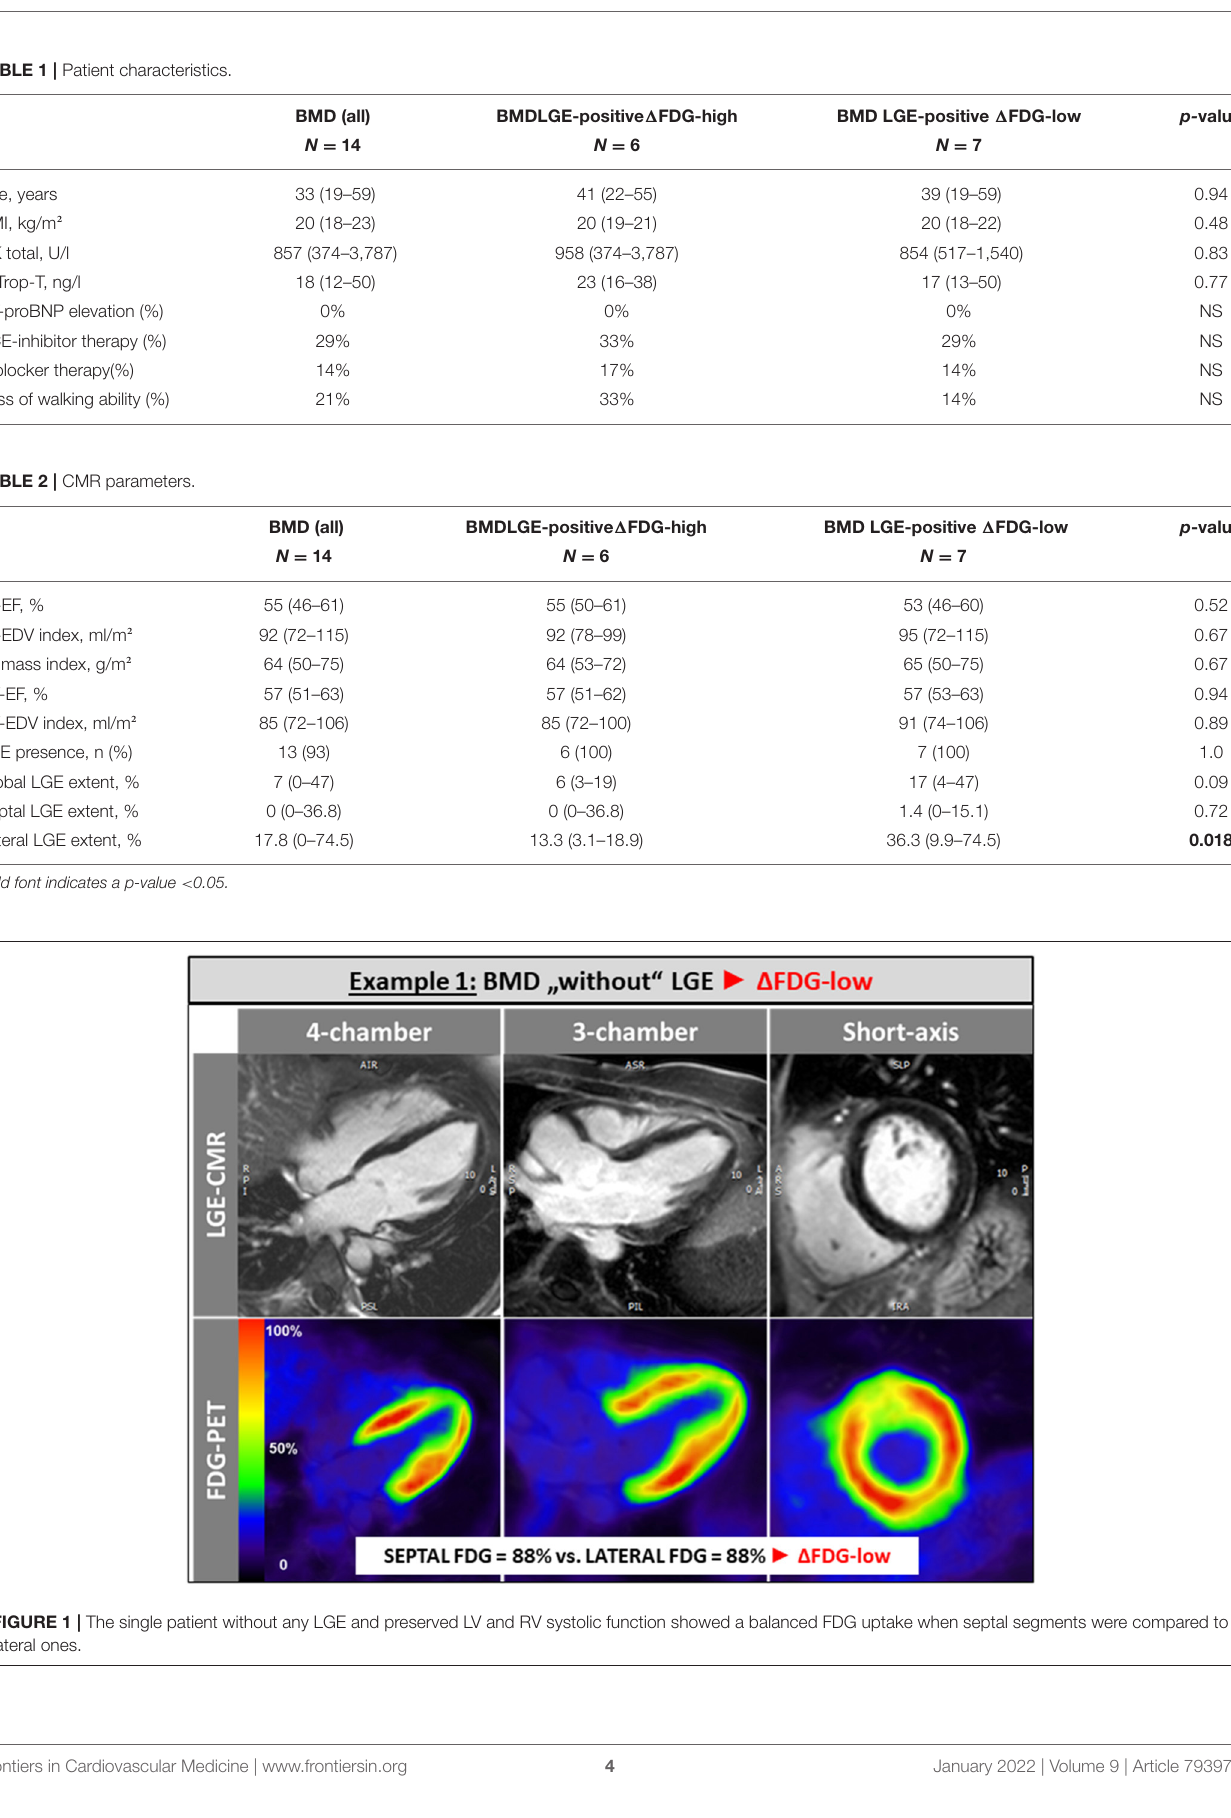
Frontiers in Cardiovascular Medicine |